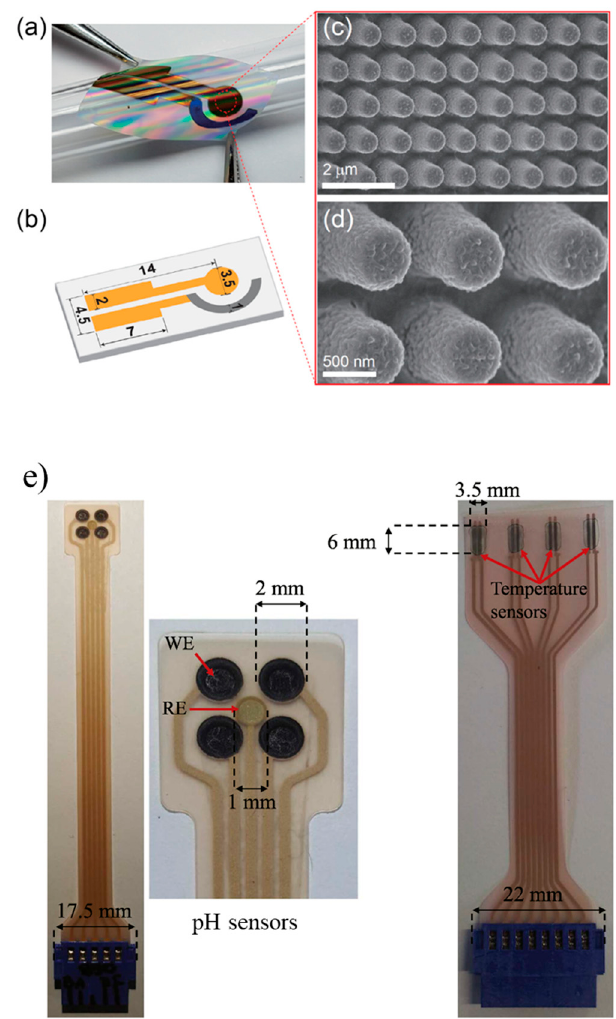
Figure 5. ( a ) An example of a flexible PAN pH sensor with ( b ) sensor dimensions; ( c , d ) SEM images of the PAN sensor (Reprinted with permission from [128]); ( e ) examples of the pH (left) and temperature (right) screen-printed sensors to use in direct contact with a wound (Reprinted with permission from [120]).